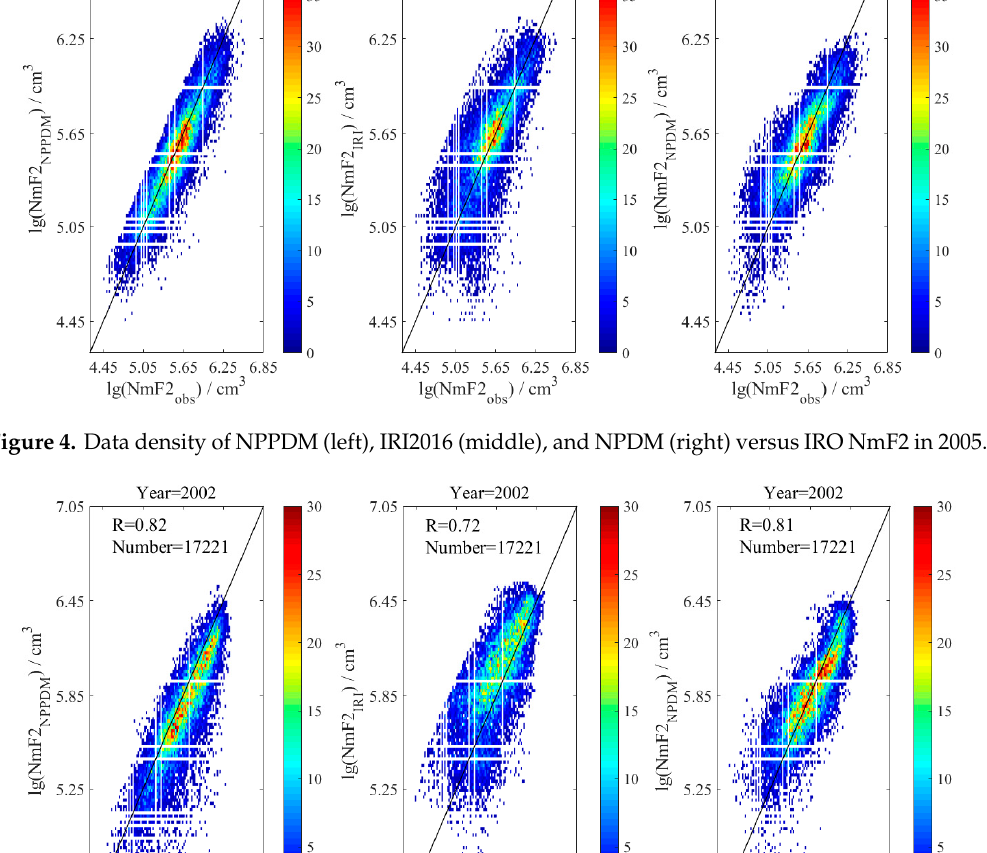
Figure 5. Same as Figure 4, but for 2002.